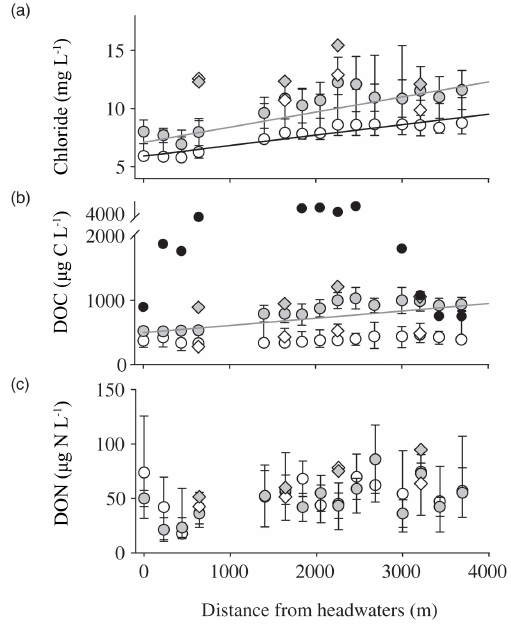
Figure 2. Longitudinal patterns of (a) chloride, (b) dissolved or- ganic carbon (DOC), and (c) dissolved organic nitrogen (DON) concentrations in stream water along the 3.7km reach. Symbols are median values and whiskers are the interquartile range (25th, 75th percentiles) for the main stream (circles) and tributaries (di- amonds). Concentrations are shown separately for the LLF (grey) and non-LLF periods (white). Black circles in (b) correspond to the field campaign of November 2010 when DOC concentrations were higher than for the remaining study period. Model regressions are indicated with solid lines only when significant (tributaries not in- cluded in the